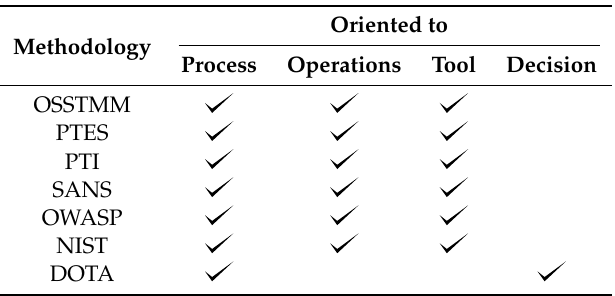
Table 5. Comparative methodology